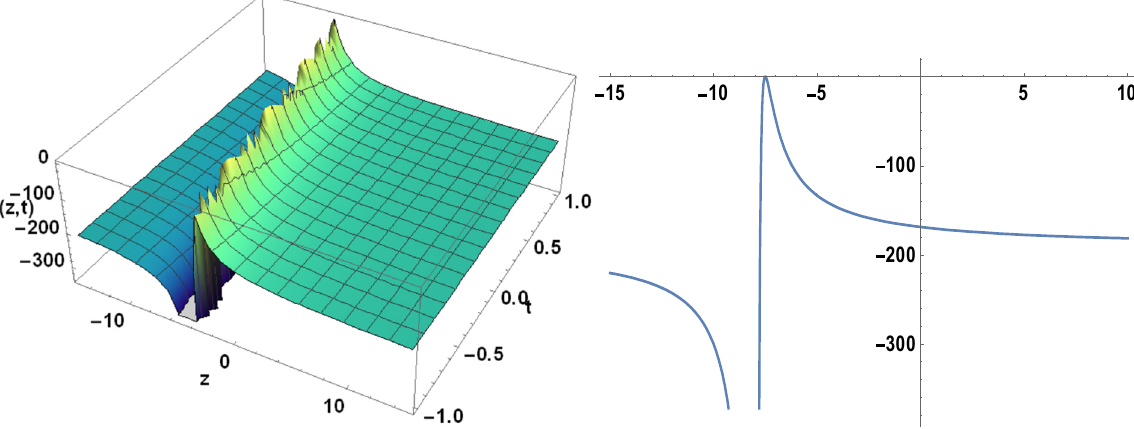
Figure 10. The 3D and 2D plots of Equation (60) for various values of parameters.